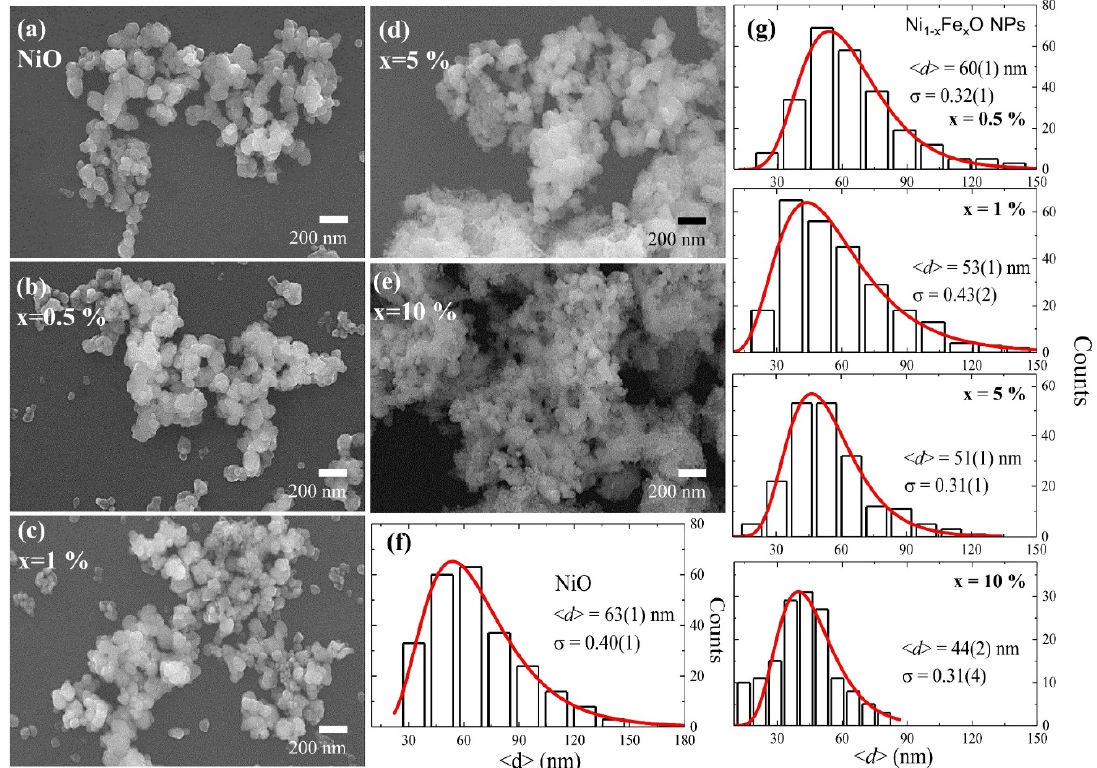
Figure 1. ( a – e ) SEM images of NiO, 0.5, 1, 5 and 10% samples, respectively. Histogram obtained from ( f ) NiO, ( g ) 0.5, 1, 5, and 10% samples (top to bottom). The solid red lines represent a fit using the Log-normal distribution function.